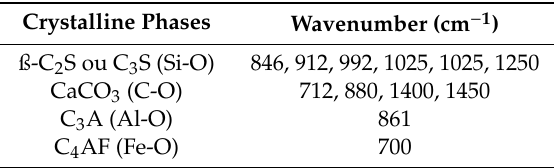
Figure10. FTIRspectraoftheconventionalclinkerandtheclinkersAandBproducedbymechanosynthesis. Figure 10. FTIR spectra of the conventional clinker and the clinkers A and B produced by Table 2. Assignment of FTIR peaks of mechanosynthesis.